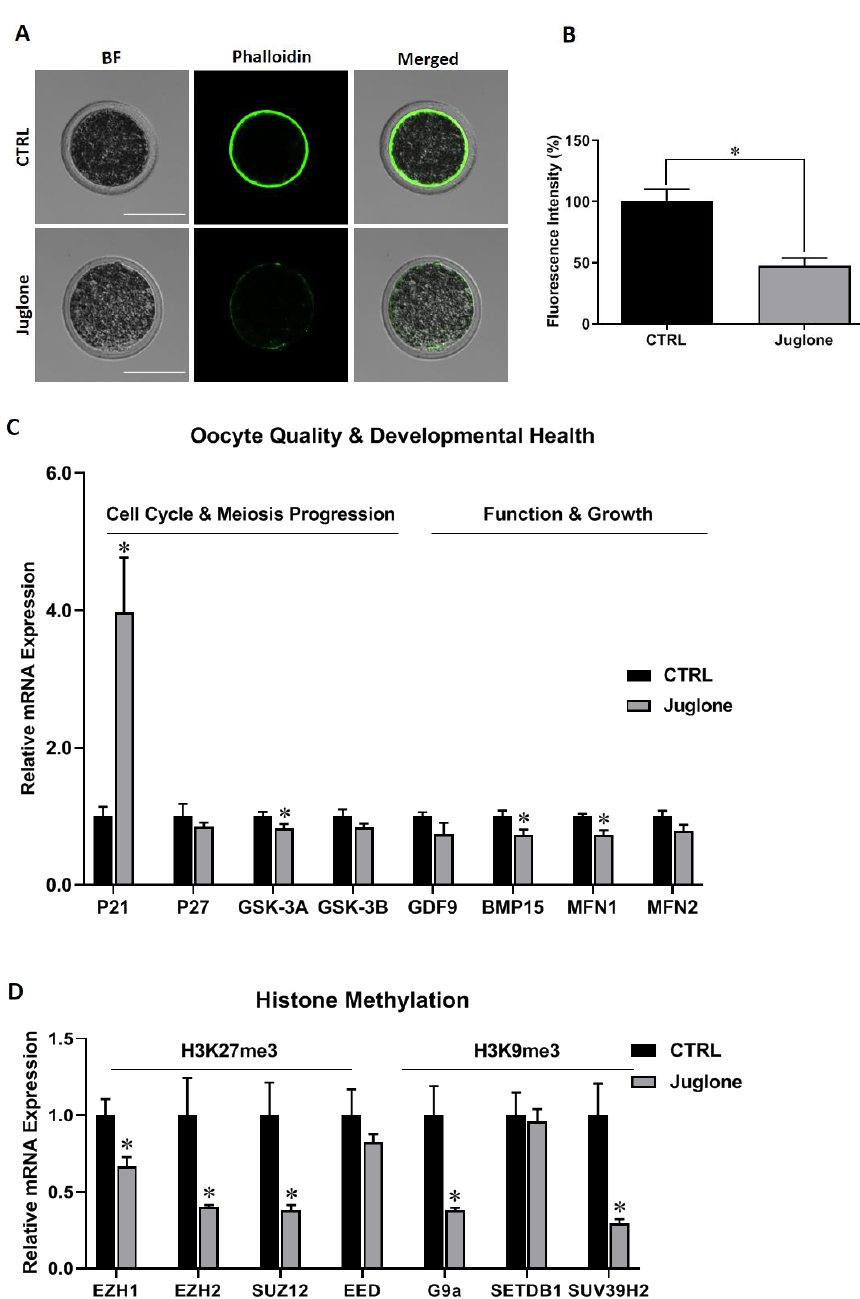
Figure 1. The effect of juglone treatment on the quality and developmental health of bovine oocytes. Oocytes were treated with 25 µ M of juglone during in vitro maturation (IVM), four replicates (n = 20), and three replicates (n = 50) were used for determining the filamentous actin (F-actin) and RT-qPCR experiments, respectively. ( A ) Phalloidin-based staining explored the distribution of F-actin in oocytes. ( B ) Fluorescence intensity of stained F-actin in treated and untreated oocytes. ( C , D ) Relative expression of oocyte quality- and development- related genes. ( C ) The mRNA levels of P21, P27/GSK-3A, GSK-3B/ GDF9, BMP15/MFN1, MFN2 regulating cell cycle, meiosis progression, oocyte function and mitochondrial fusion, respectively. ( D ) The mRNA levels of histone methylation H3K27me3 (EZH1, EZH2, SUZ12, and EED), and H3K9me3 (G9a, SETDB1 and SUV39H2)-related methyltransferases. Scale bar = 100 µ m. Columns with an asterisk (*) indicate statistical significance. BF: Bright